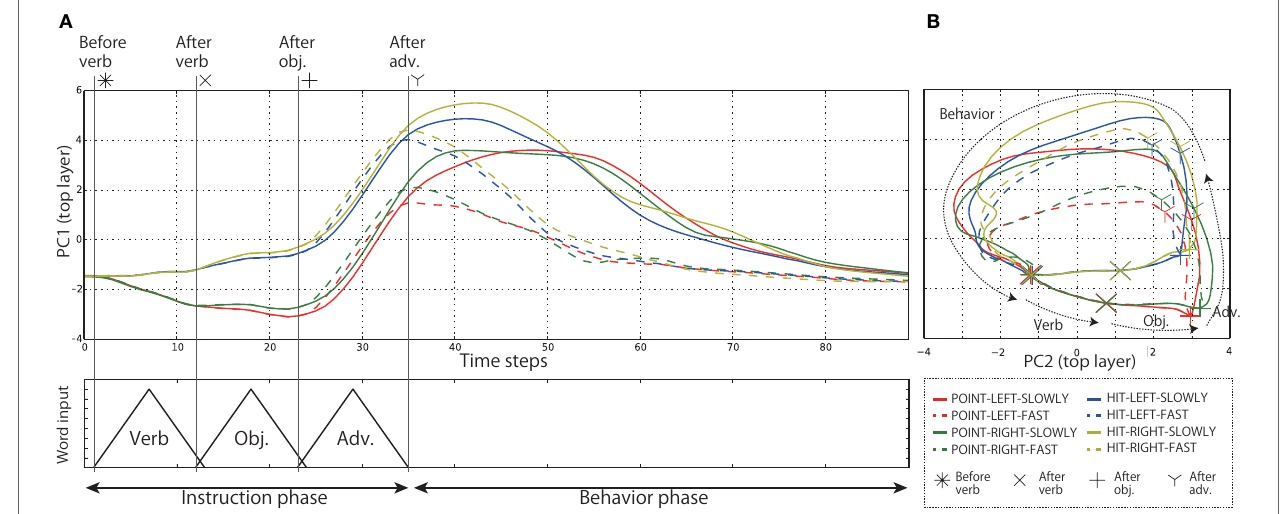
FIGURE 8 | (A) The time development of the internal states in the top layer in the PC1 direction. Each line expresses the time development averaged over all the episodes in which each behavior was generated during evaluation. The episodes in which the instruction consists of four words were excluded. The internal states of the top layer develop along branches corresponding to the meaning of the input words. (B) The same time development projected onto PC1–PC2 space. The cyclic structure directly representing the temporal flows of interaction, which consist of the repetition of instruction recognition and behavior generation, can be seen. This representation corresponds to the top panel of Figure 1